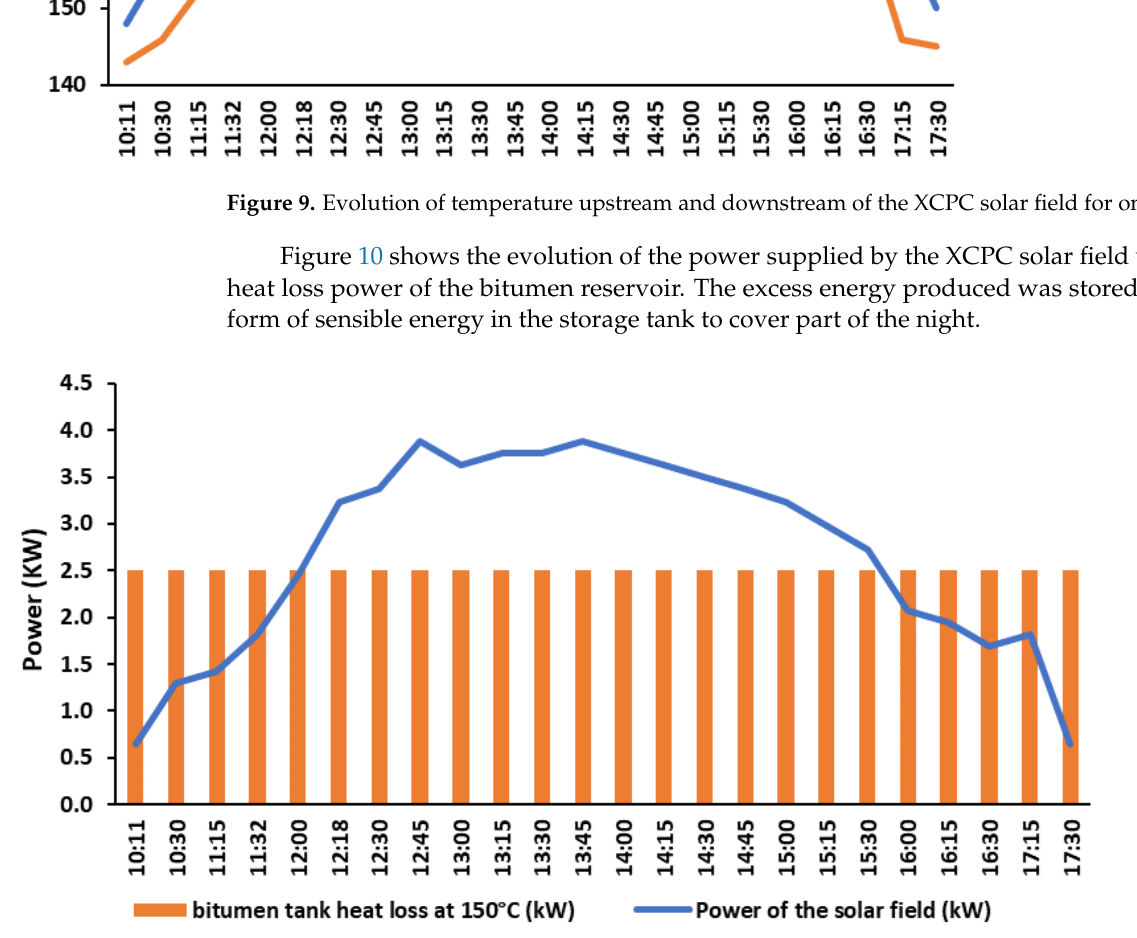
Figure 10. Evolution of the power supplied by the XCPC solar field vs. the bitumen tank heat loss.